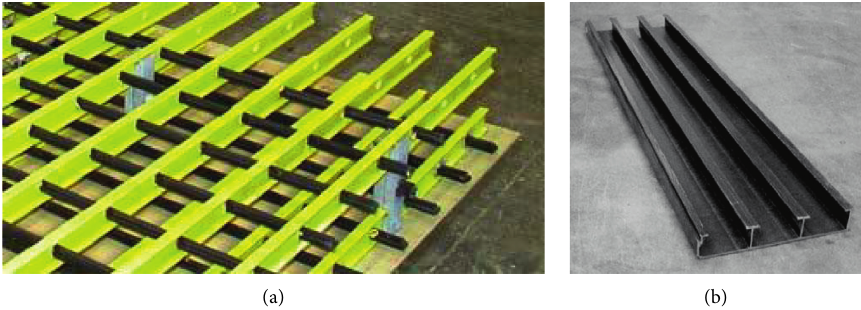
Figure 18: Mechanical interlocking connection type. (a) Grids connection. (b) T-ribs connection.